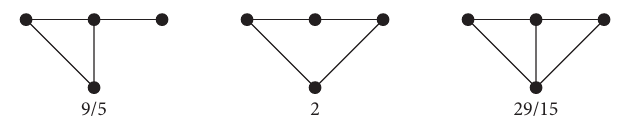
Figure 2: Quasi-tree graphs of order 4 and their harmonic indices.